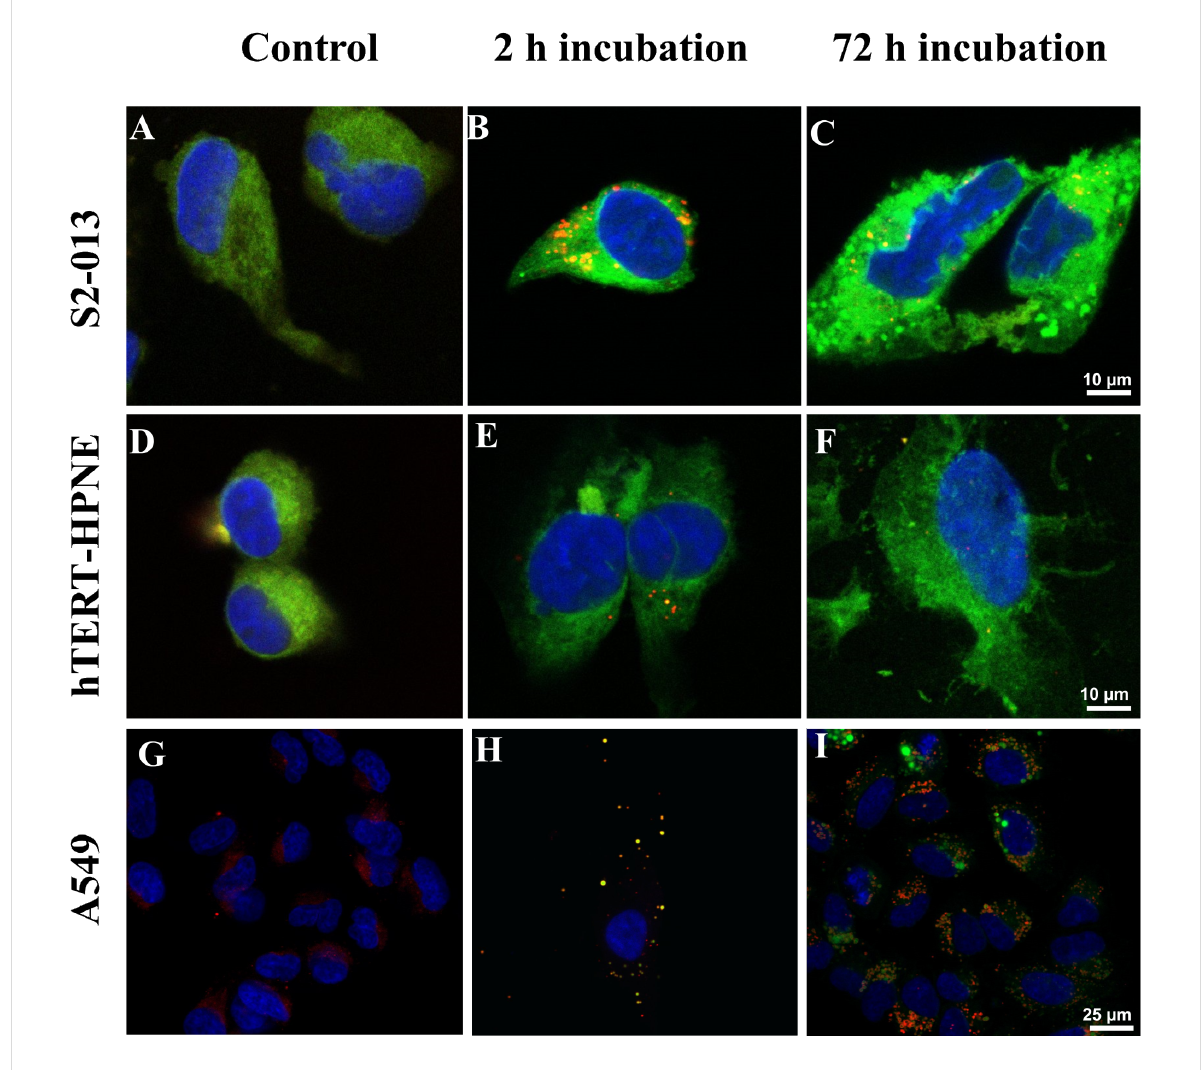
Figure 3: Confocal laser scanning microscopy images of human cells treated with calcitriol entrapped in C6-PLGA NPs. S2-013 cells: (A) control cells; cells after (B) 2 and (C) 72 h of incubation with C6–calcitriol–PLGA NPs. hTERT-HPNE cells: (D) control cells; cells after (E) 2 and (F) 72 h of incubation with C6–calcitriol–PLGA NPs. A549 cells: (G) control cells; cells after (H) 2 and (I) 72 h of incubation with C6–calcitriol–PLGA NPs. The blue color represents the nuclei and the yellow color represents the colocalization of PLGA NPs with the late endosomes/lysosomes. Scale bar: 10 µm for images A–F, and 25 µm from